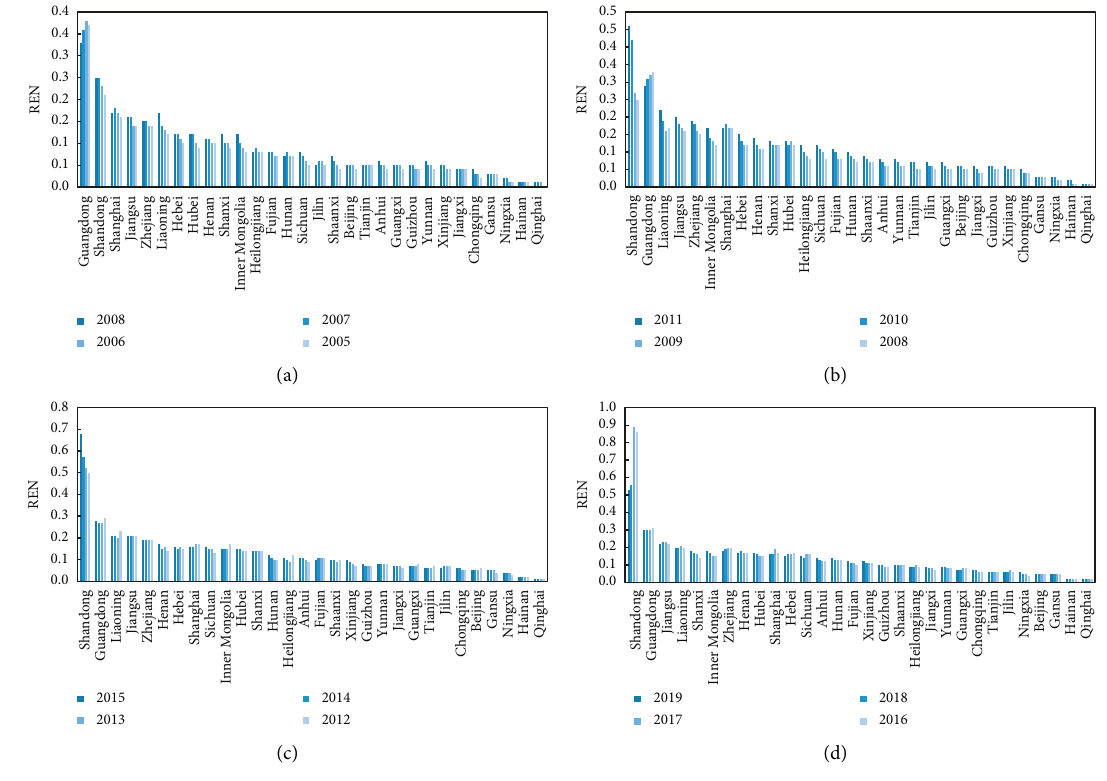
Figure 4: China’s EEE subsystem-REN (2005 ∼